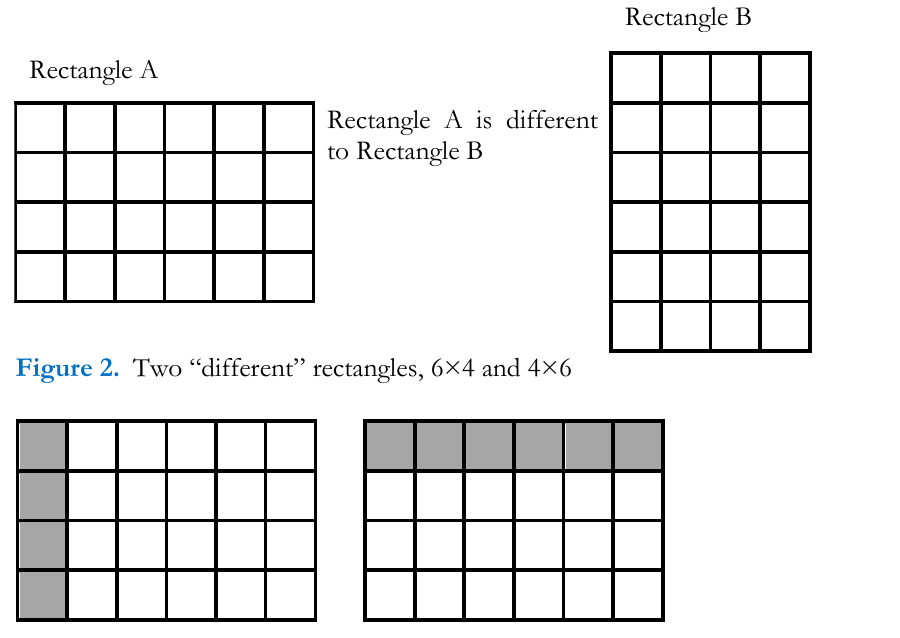
Figure 3. Overlaying Rectangle A with different